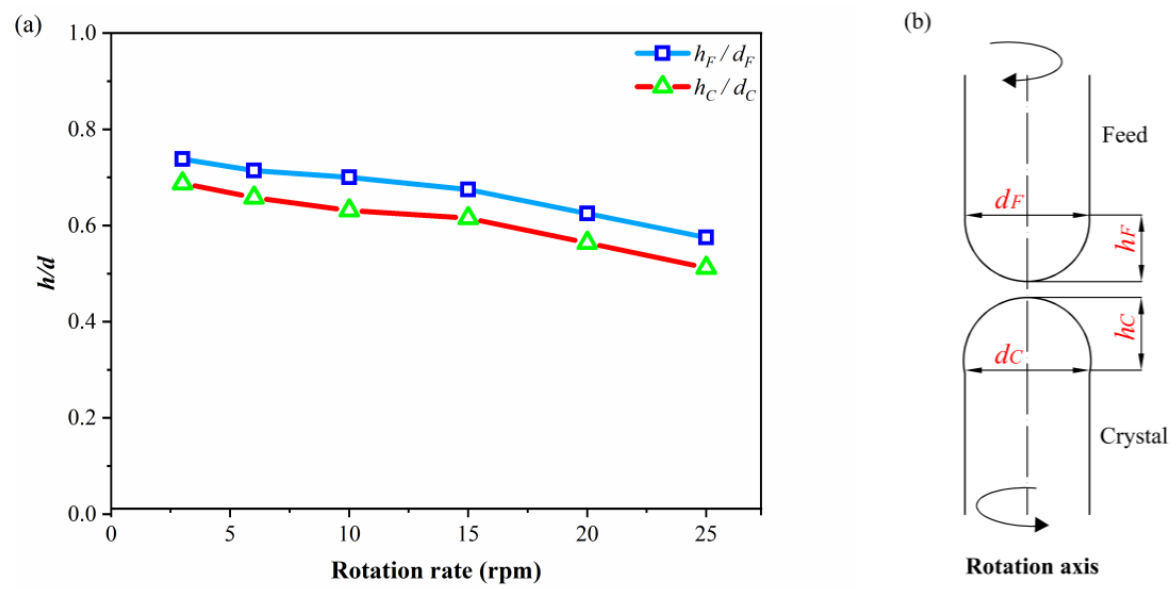
Figure 3. ( a ) Variation in the convexity ( h/d ) under different rotation rates and ( b ) a schematic diagram showing the definition of convexity ( h/d ).